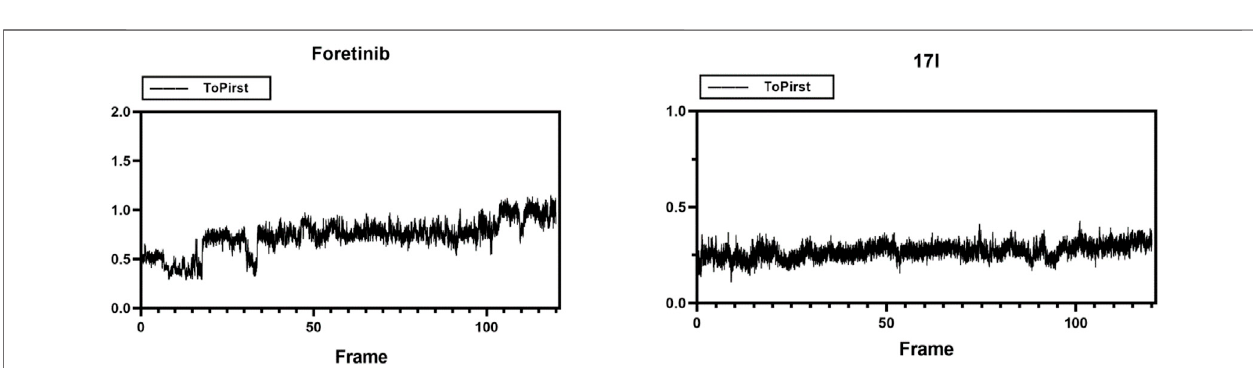
FIGURE 10 | Root-mean-squared deviation (RMSD) plots for the backbone atoms and foretinib or 17l during 120-ns MD simulations. The X axis is the frame number. The Y axis is the RMSD value.